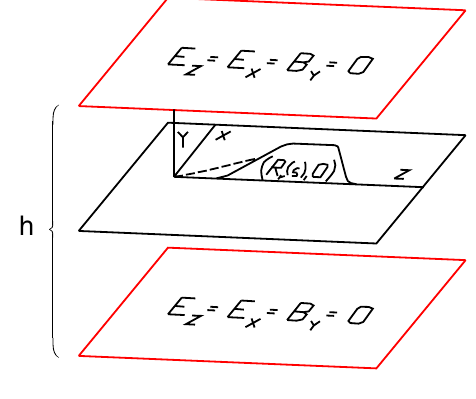
FIG. 1. Basic lab system